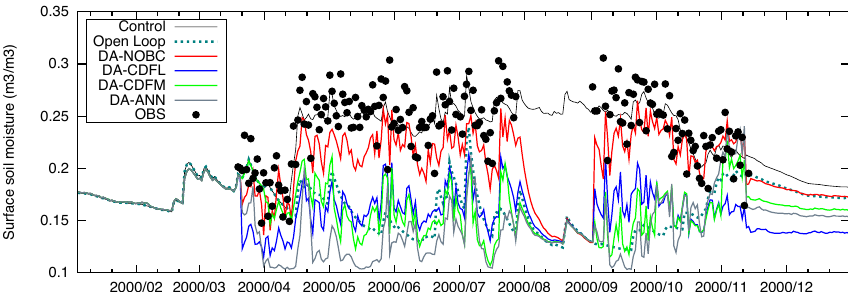
Figure 10. Time series of simulated observations, Control, open loop and various DA integrations for the year 2000. DA-NOBC assimilates observations directly without any bias correction, DA-CDFL assimilates a priori-scaled observations using CDF matching (using lumped CDFs), DA-CDFM assimilates a priori-scaled observations using monthly CDF matching and DA-ANN assimilates the simulated observa- tions directly and using a trained ANN as the observation operator in the data assimilation system.